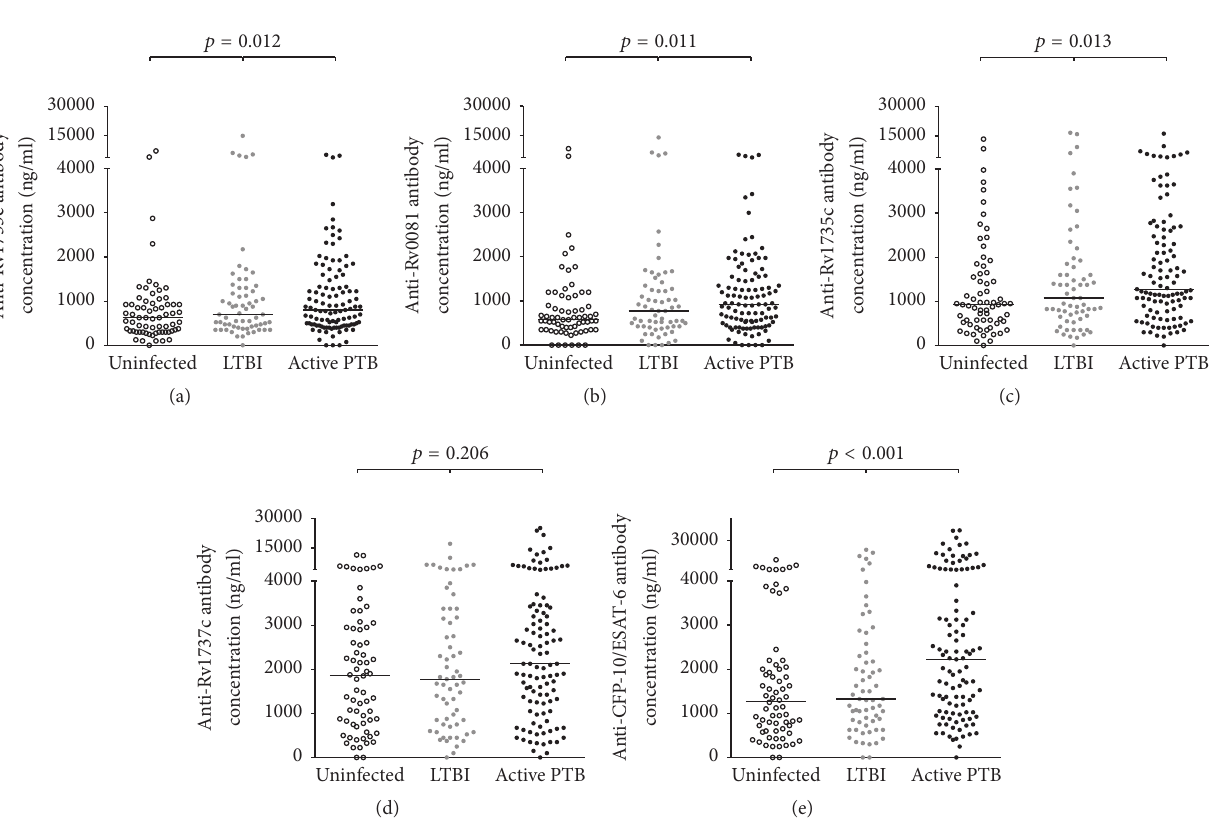
Figure 1: Scatter dot plots showing IgG antibody concentrations. The tuberculin skin test (TST) and the QuantiFERON TB Gold In-Tube (QFT) were used to determine if individuals were uninfected or had latent tuberculosis infection (LTBI). Sputum smear microscopy was used to define APTB cases. The horizontal bars shown are median concentrations of IgG antibodies in each group. The 𝑝 values shown correspond to results from Kruskal–Wallis